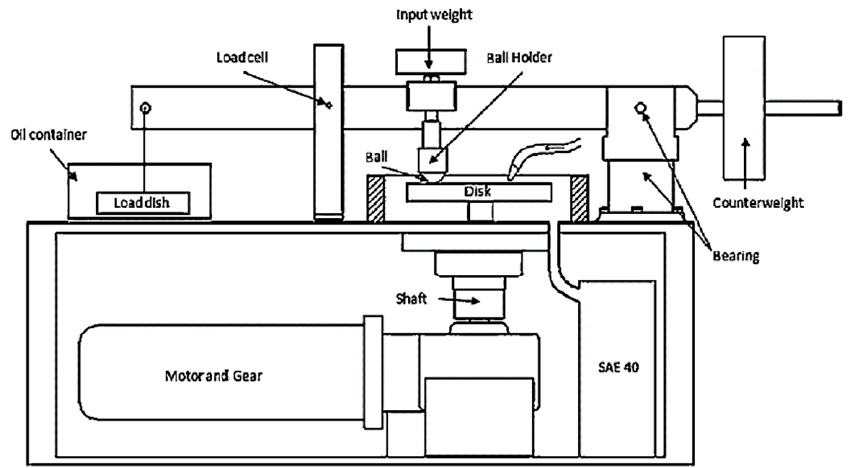
Figure 1. Ball-on-disc tribometer.